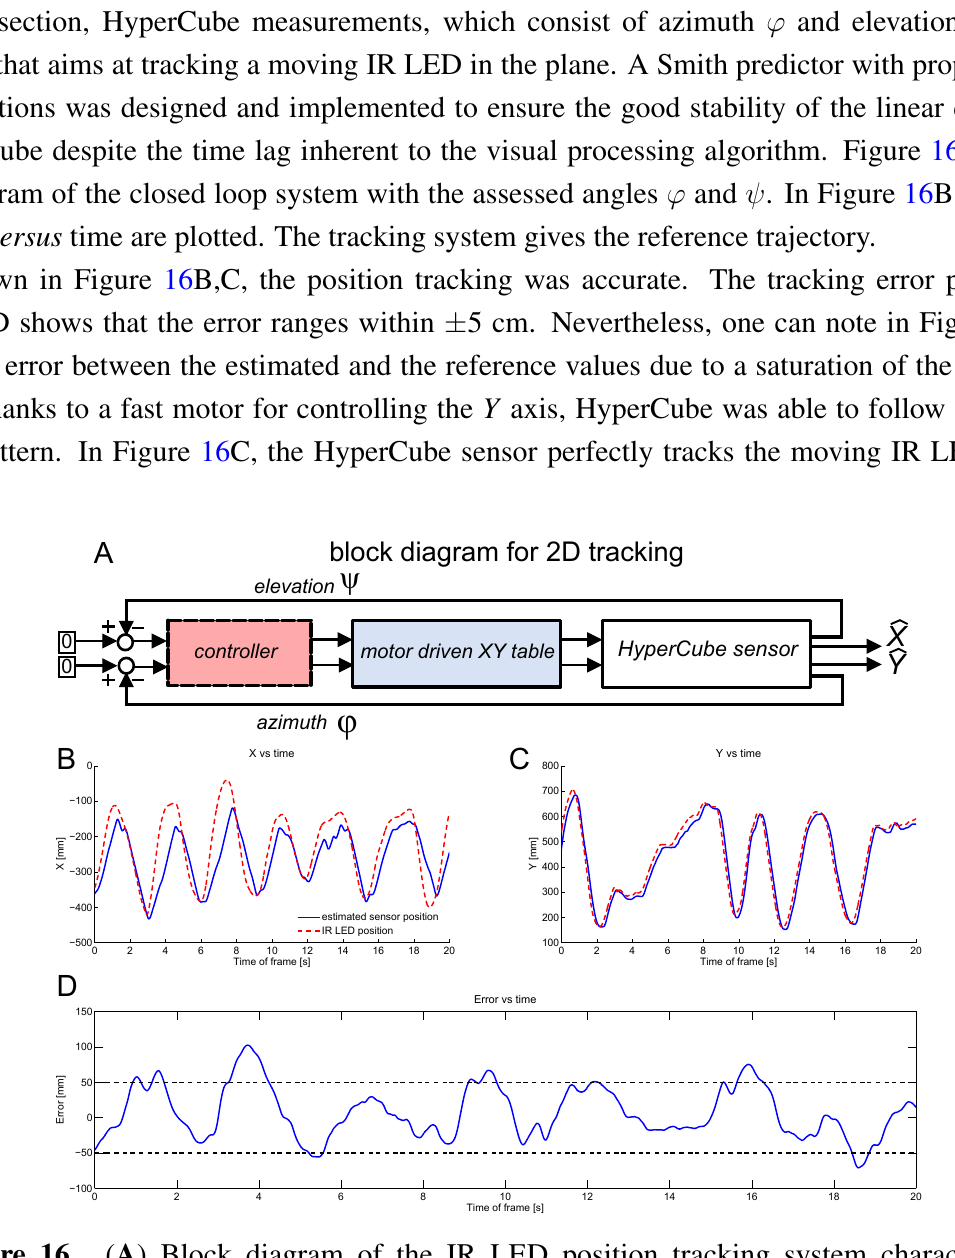
( A ) Block diagram of the IR LED position tracking system characterized by moving by hand one IR LED (flickering frequency of 1 kHz) placed 30 cm above HyperCube; ( B ) experimental recording of the position tracking along the X direction versus time. The DC motor dynamics in charge of moving HyperCube along the X axis was a bit too slow to follow faithfully the quick variations of the reference input signal; ( C ) experimental recording of the position tracking along the Y direction versus time; ( D ) error of the IR LED position tracking. Note that the absolute value of the position error never exceeds 10